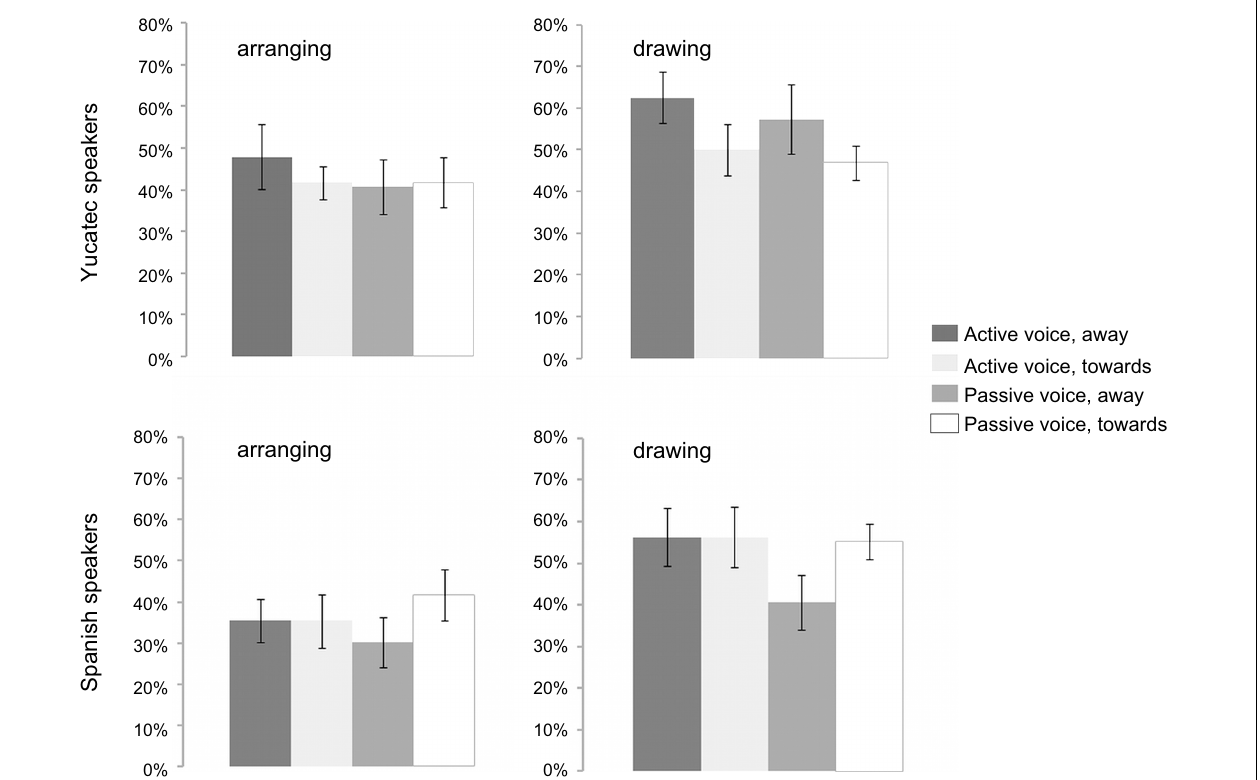
FIGURE 1 | Percentage left-placements as a function of condition and language ( t -bars represent one SE).